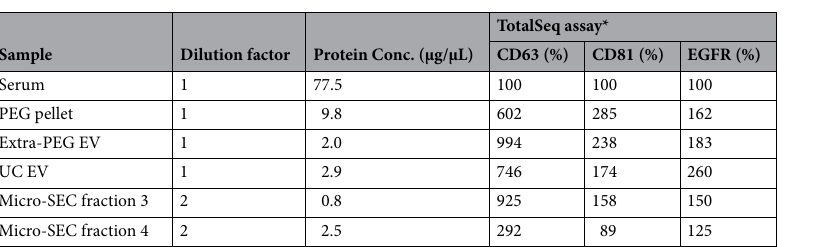
Sample Dilution factor Protein Conc.